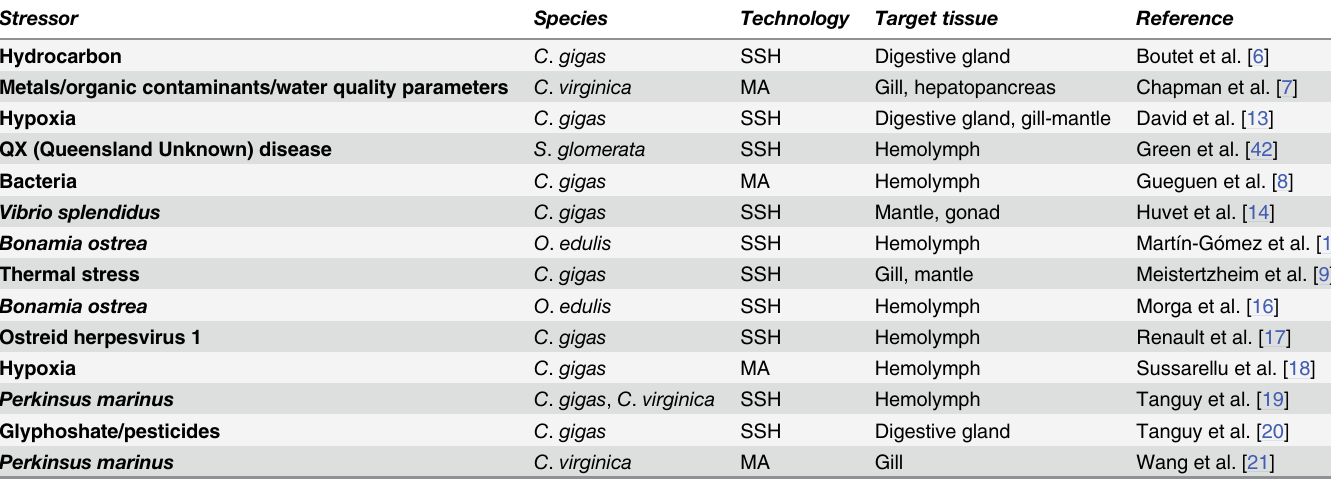
Table 2. Studies used in this meta-analysis.